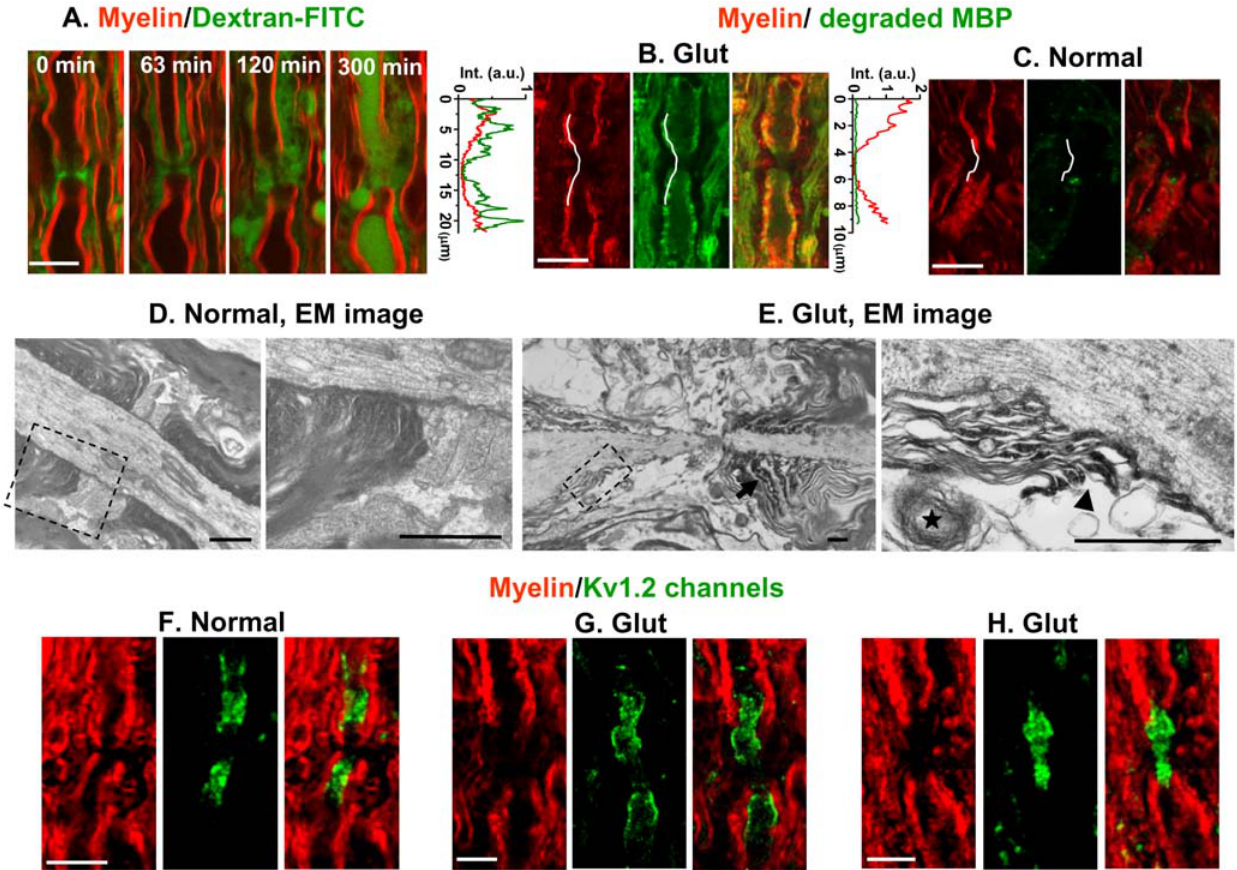
Figure 2. Glutamate application breaks axo-glial junctions, disrupts paranodal myelin and subsequently exposes juxtaparanodal K + channels. (A) Time-lapse images showing the leakage of dextran-FITC into the split myelin after glutamate application. The myelin (red) and dextran-FITC (green) were monitored by CARS and TPEF, simultaneously. (B) and (C) CARS images of myelin sheath (red) and confocal fluorescence images of degraded MBP (green) in spinal tissues after incubation in 1 mM glutamate solution (Glut) or normal Krebs’ solution (Normal). The curves on the left of the images are intensity profiles of the lines indicated in the images. (D) EM images in a normal tissue show the paranodal myelin held in tight contact with the axolemma. The right panel is the magnified image of the dash frame in the left panel. (E) EM images show that glutamate induces paranodal myelin splitting (arrow), disruption and retraction. The right panel is the magnified image of the dash frame in the left panel. An elongated node, detachment of paranodal myelin from axolemma (arrow head), and disrupted myelin debris (star) were observed. (F)–(H) CARS images of myelin sheath (red) and TPEF images of Kv1.2 channels (green) at the juxtaparanodes after normal Krebs’ solution (F, Normal) and application of glutamate (G–H, Glut). Both the exposure of Kv1.2 channels (G) and displacement of Kv1.2 channels into paranodes and node (H) were observed. For (D) and (E), bar=1 m m. For (A)–(C) and (F)–(H), bar=10 m m.